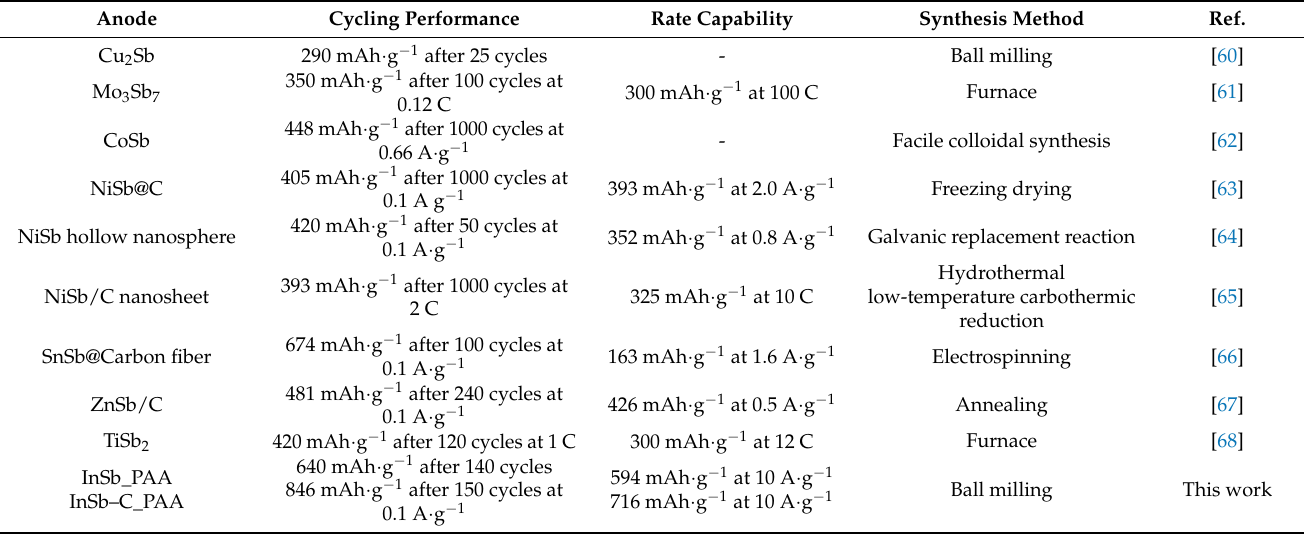
Figure 8. Illustration of the InSb–C_PAA reaction mechanism. Table 1. Performance comparison of intermetallic Sb-based anodes for LIBs.